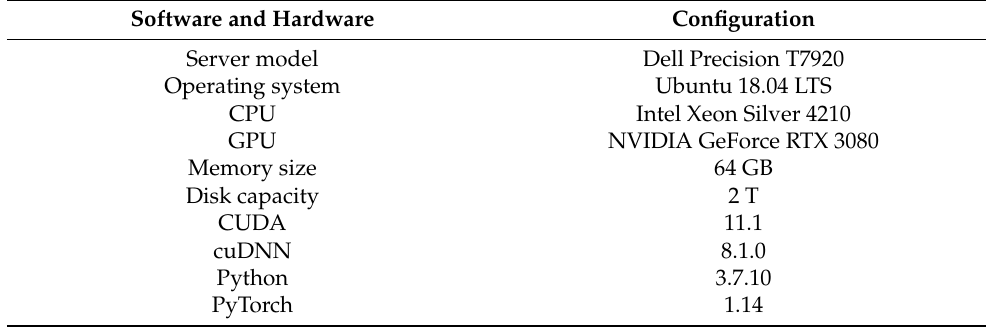
Table 6. The experimental environment. Software and